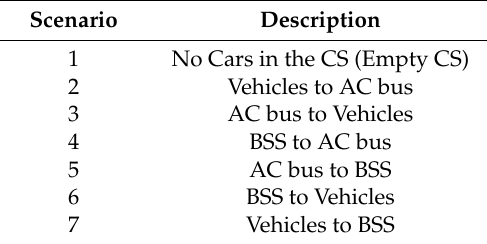
Table 4. Possible